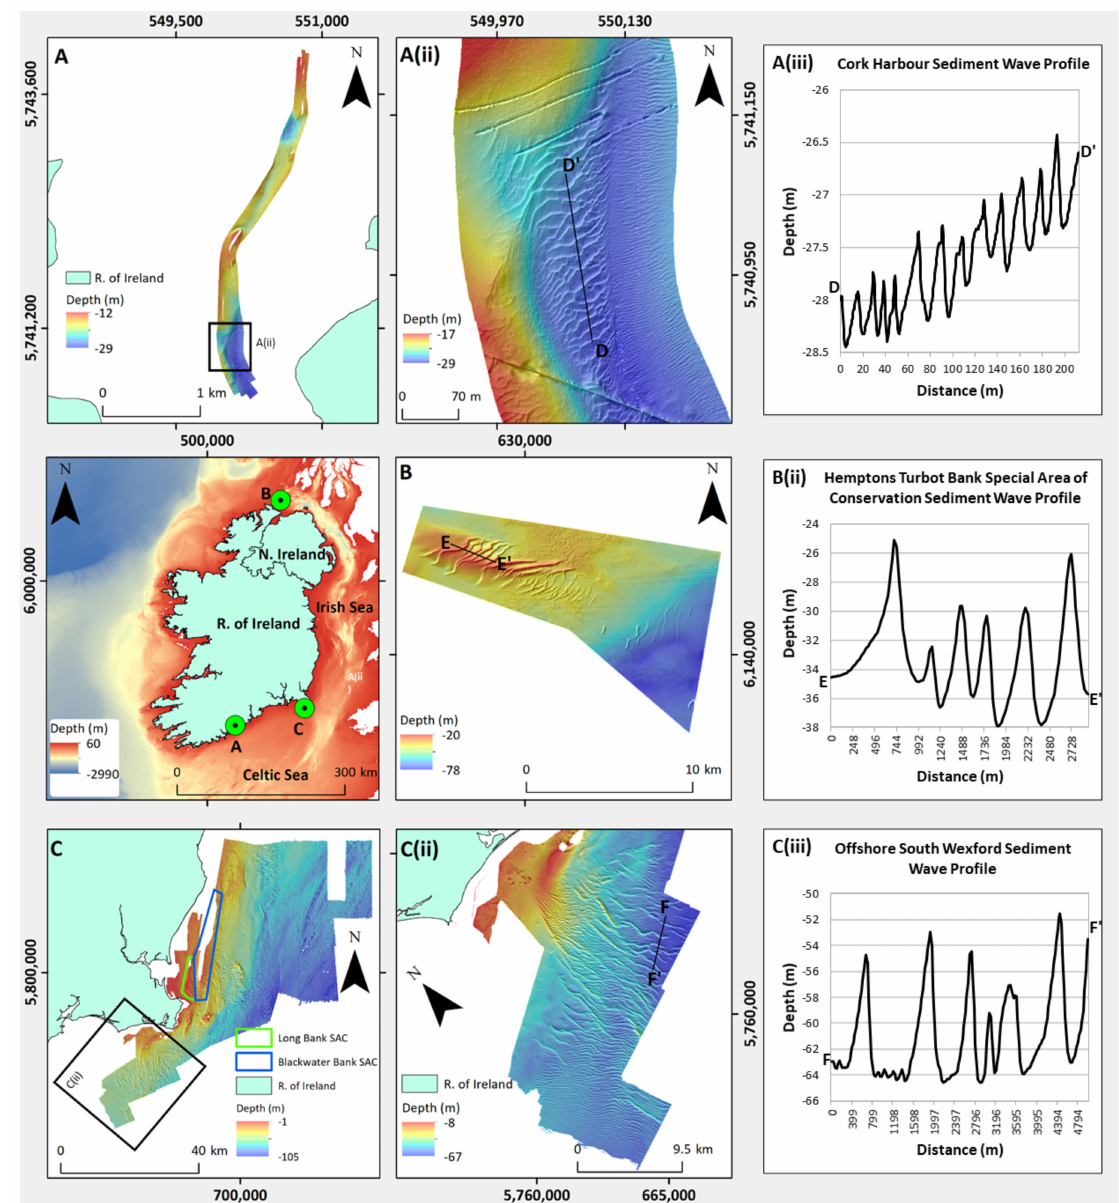
Figure 1. Map showing the location of the three study sites with details of sediment waves images on MBES bathymetric data. ( A ) Cork Harbour high-resolution bathymetry displaying extent of ( A ( i ); A ( ii )) South Cork Harbour with the line D–D’ for the sediment wave profile in ( A ( iii )); ( B ) Hemptons Turbot Bank SAC low-resolution bathymetry (acquired from EMODnet) with the line E–E’ for the sediment wave profile in B ( ii ); ( C ) Offshore South Wexford (OSW) low-resolution bathymetry (acquired from EMODnet) displaying extent of C ( ii ) (in black) and the extent of the Blackwater Bank SAC and the Long Bank SAC ( ii ); C ( ii )) South–West OSW with the line F–F’ for the sediment wave profile in C ( iii